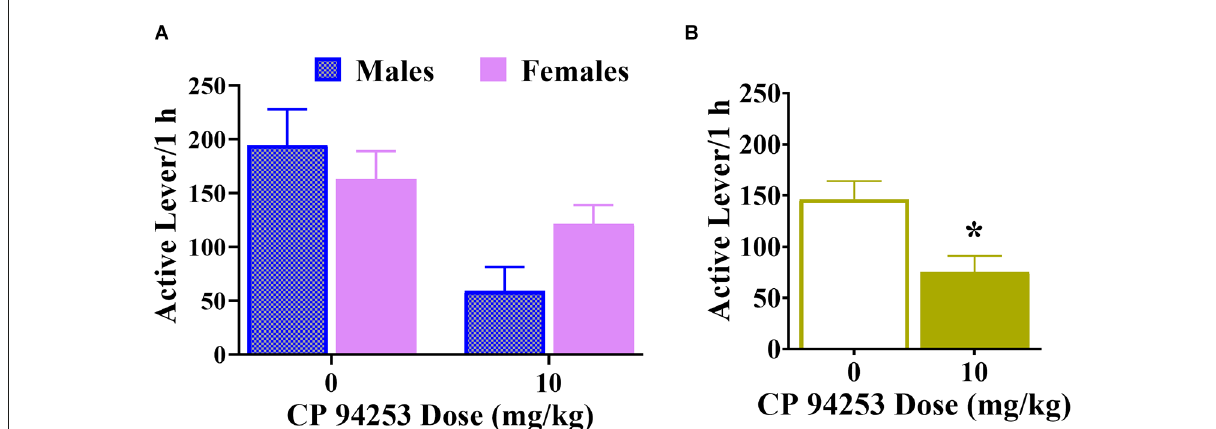
FIGURE7 Effects of CP94253 (10 mg/kg, SC) on responding during sucrose cue-reactivity test expressed as the mean ± SEM active lever presses in male ( n = 8) and female ( n = 15) rats (A) and in all rats (B) . Testing took place at least 10 days after the last training session. There were no main effects or interactions with sex. *Difference from vehicle, Bonferroni t -tests, p <